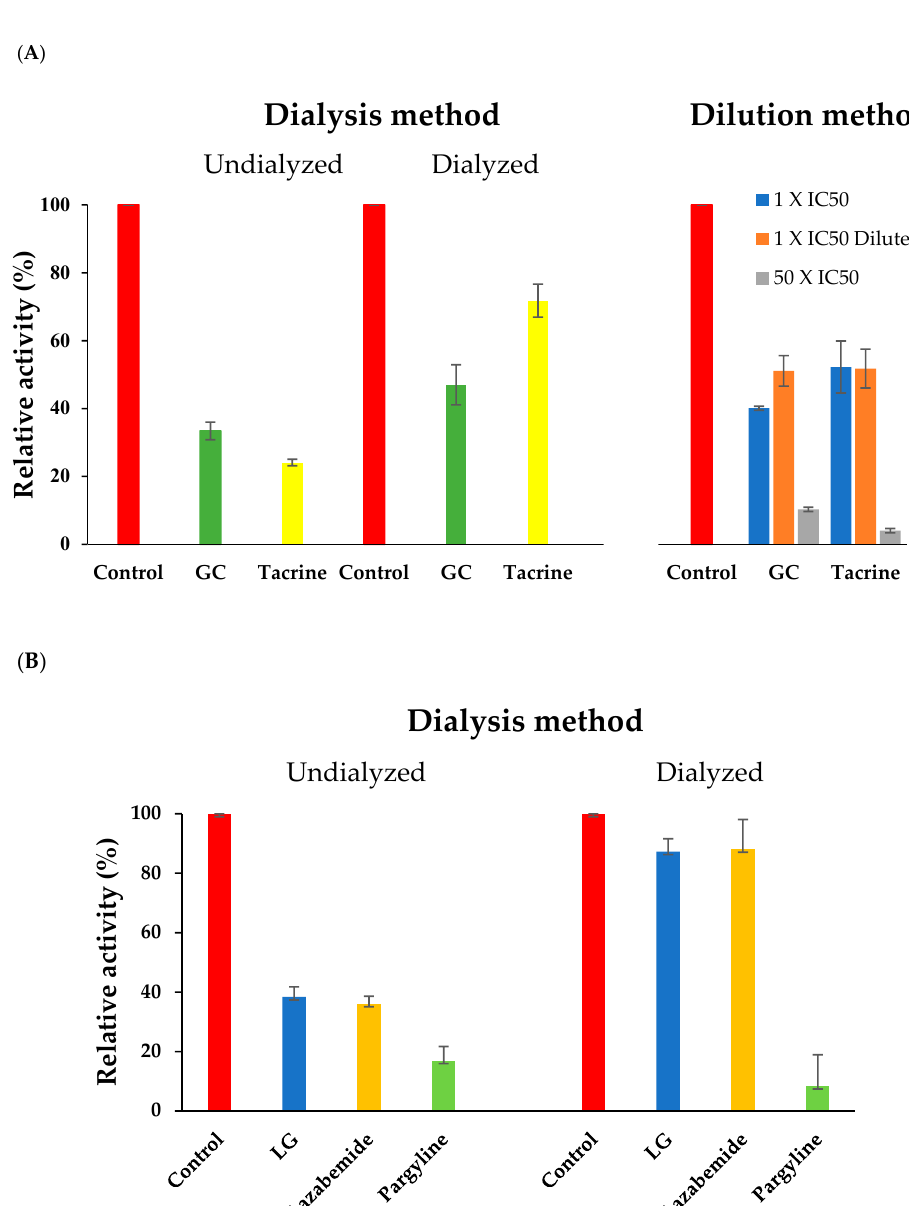
Figure 2. Recoveries of BChE inhibition by GC ( A ) and MAO-B inhibition by LG ( B ). The concentrations of the inhibitors used were: GC, 14.0 µ M; LG, 0.2 µ M; tacrine, 0.03 µ M; lazabemide, 0.12 µ M; and pargyline, 0.06 µ M. In the dilution experiments, we measured residual activities of BChE at an inhibitor concentration of 1 × IC 50 , at a concentration of 50 × IC 50 and then diluted to a concentration of 1 × IC 50 after preincubation, at an inhibitor concentration of 50 × IC 50 . Results are the averages of duplicate or triplicate (GC dialysis) experiments. Tacrine was used as a reversible reference BChE inhibitor. Lazabemide and pargyline were used as reversible and irreversible reference MAO-B inhibitors, respectively.